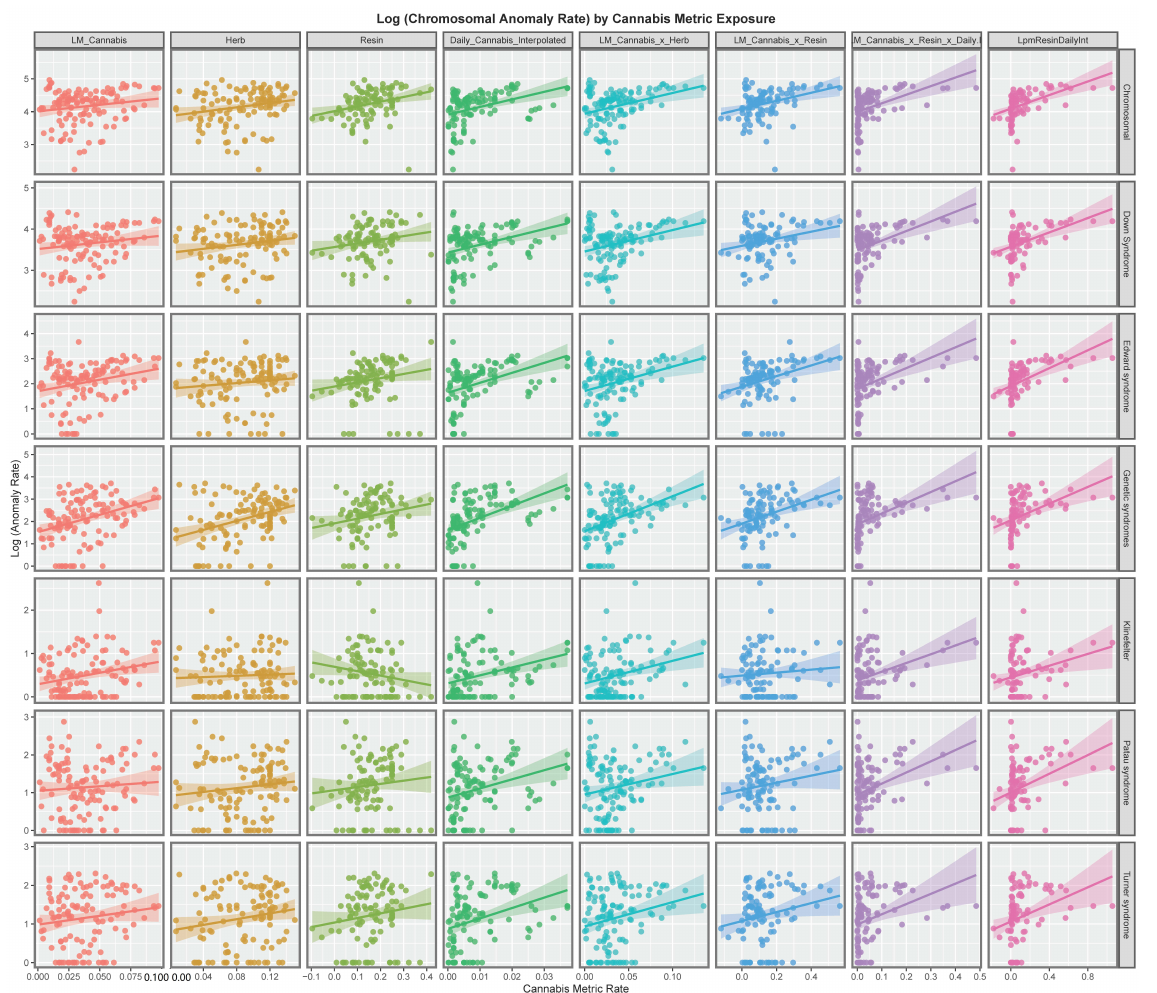
Figure 2. Panelled scatterplots of log (chromosomal and genetic disorder rates) by various cannabis